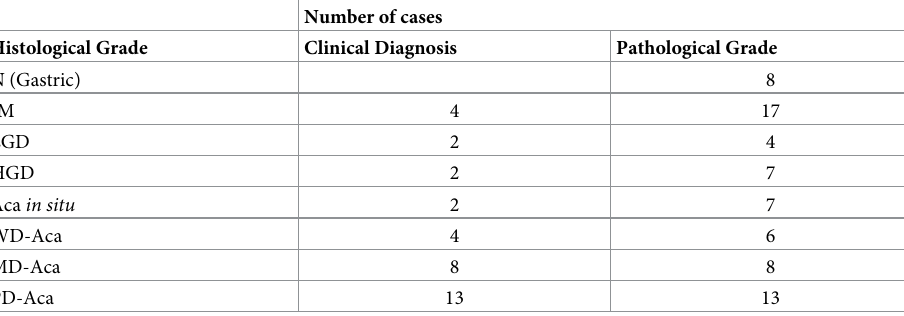
Table 1. Human GEJ